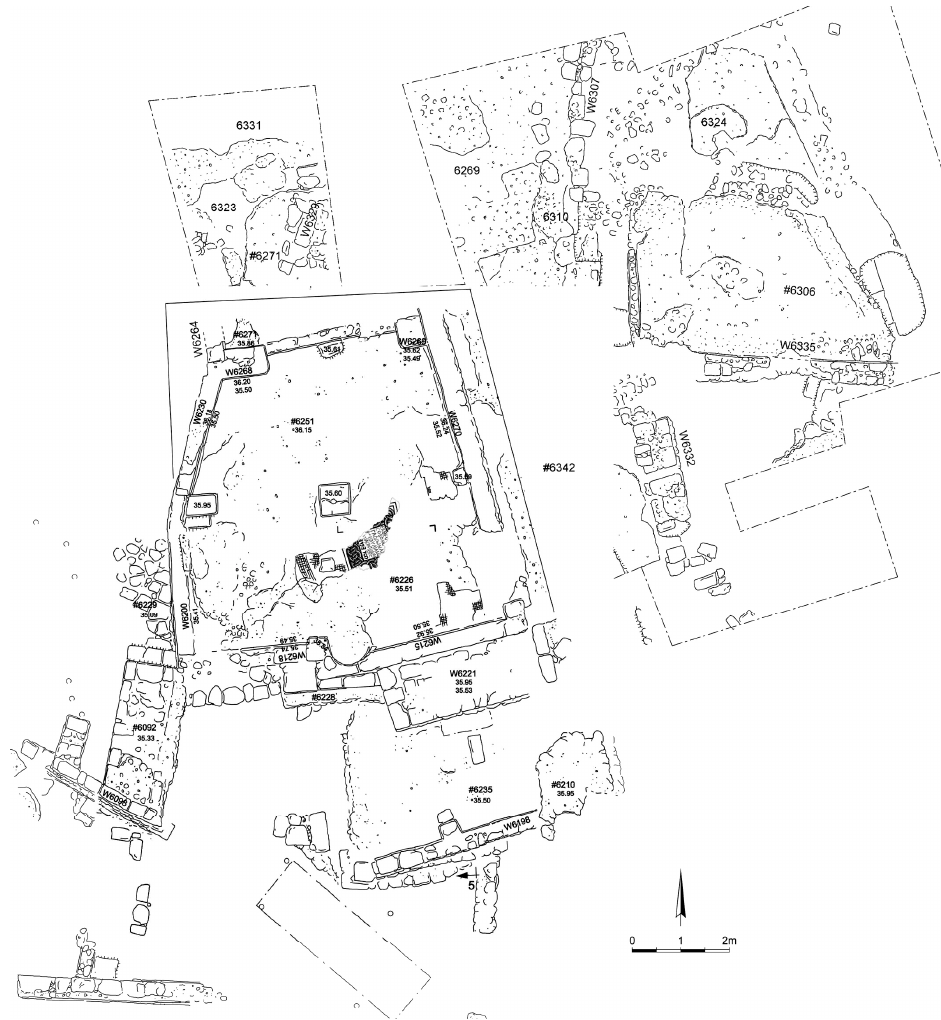
Figure 2. Apollonia-Arsuf, plan of Area P1 (after the 2015 season of excavations) (Slava Pirsky).